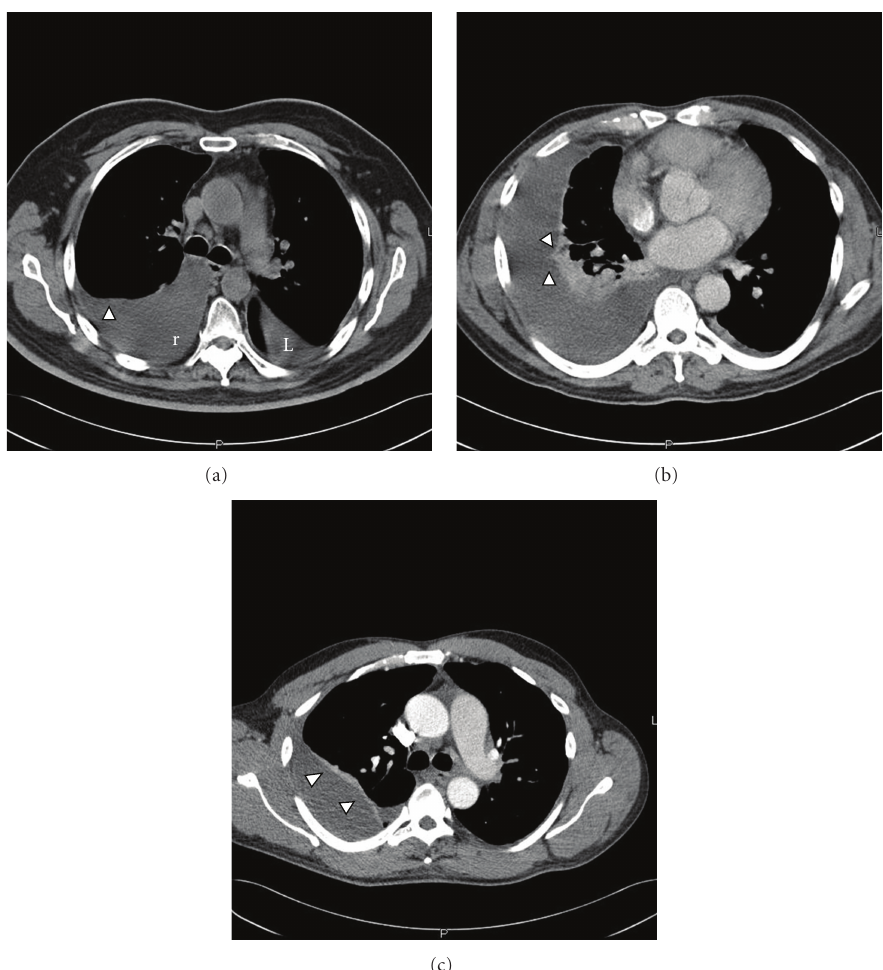
Figure 1: A series of CT images done in patient with parapneumonic e ff usions. (a) CT image showing a free flowing pleural e ff usion (r) with a meniscus formation (arrow). There is also some fluid in the fissure on the left side (L). (b) A loculated pleural e ff usion with loculations seen in the pleural space (arrows). (c) A chronic pleural e ff usion showing marked pleural thickening